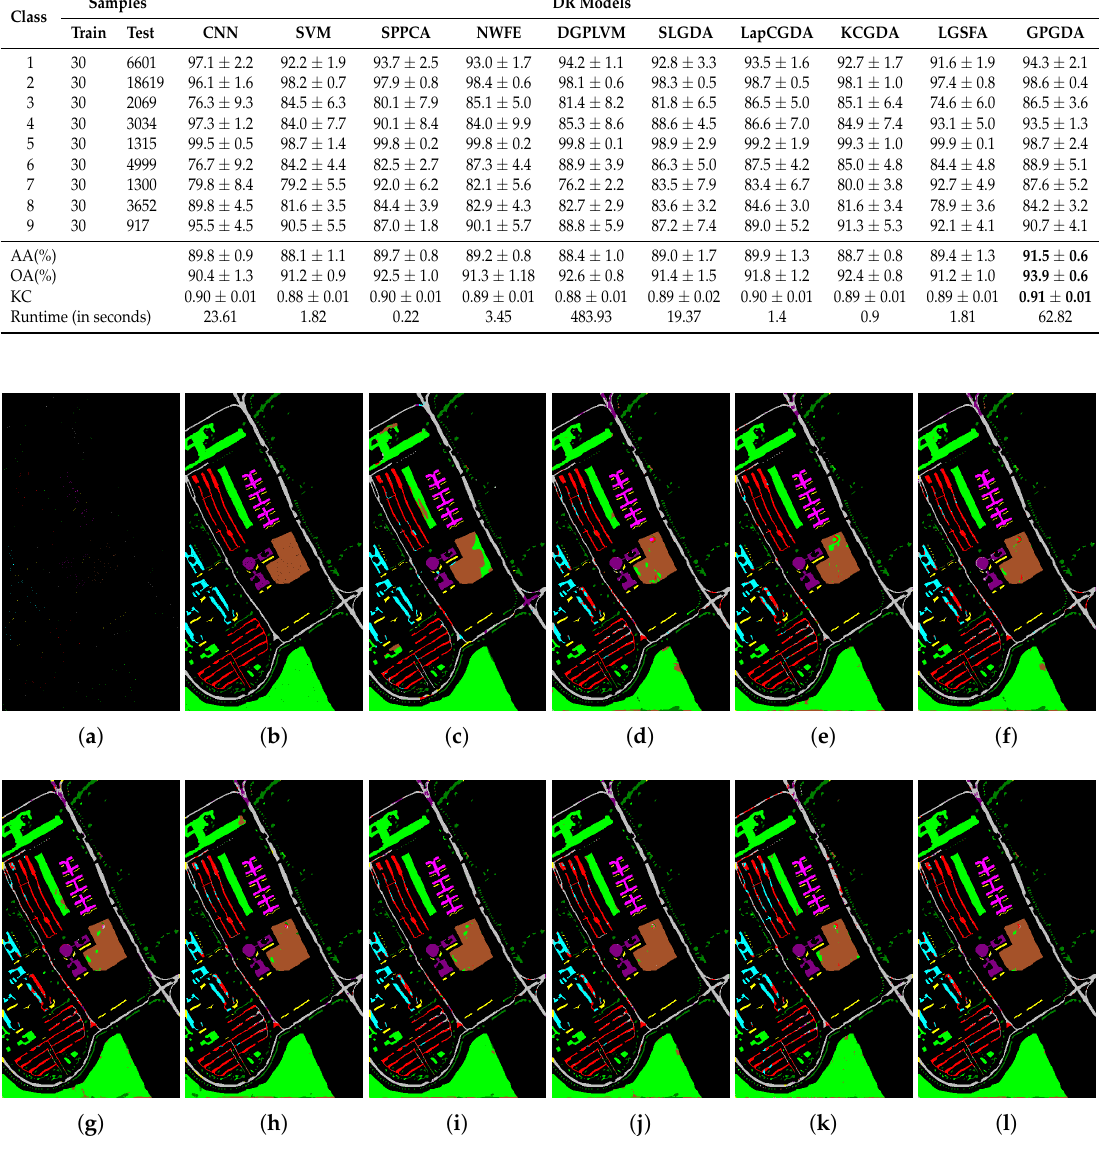
Figure 8. Classification maps of CNN and different DR models based on SVM on the University of Pavia data: ( a ) Training GT; ( b ) Testing GT; ( c ) CNN (OA = 90.4%); ( d ) SVM (OA = 91.2%); ( e ) SPPCA (OA = 92.5%); ( f ) NWFE (OA = 91.3%); ( g ) DGPLVM (OA = 92.6%); ( h ) SLGDA (OA = 91.4%); ( i ) LapCGDA (OA = 91.8%); ( j ) KCGDA (OA = 92.4%); ( k ) LGSFA (OA = 91.2%); and ( l ) GPGDA (OA =